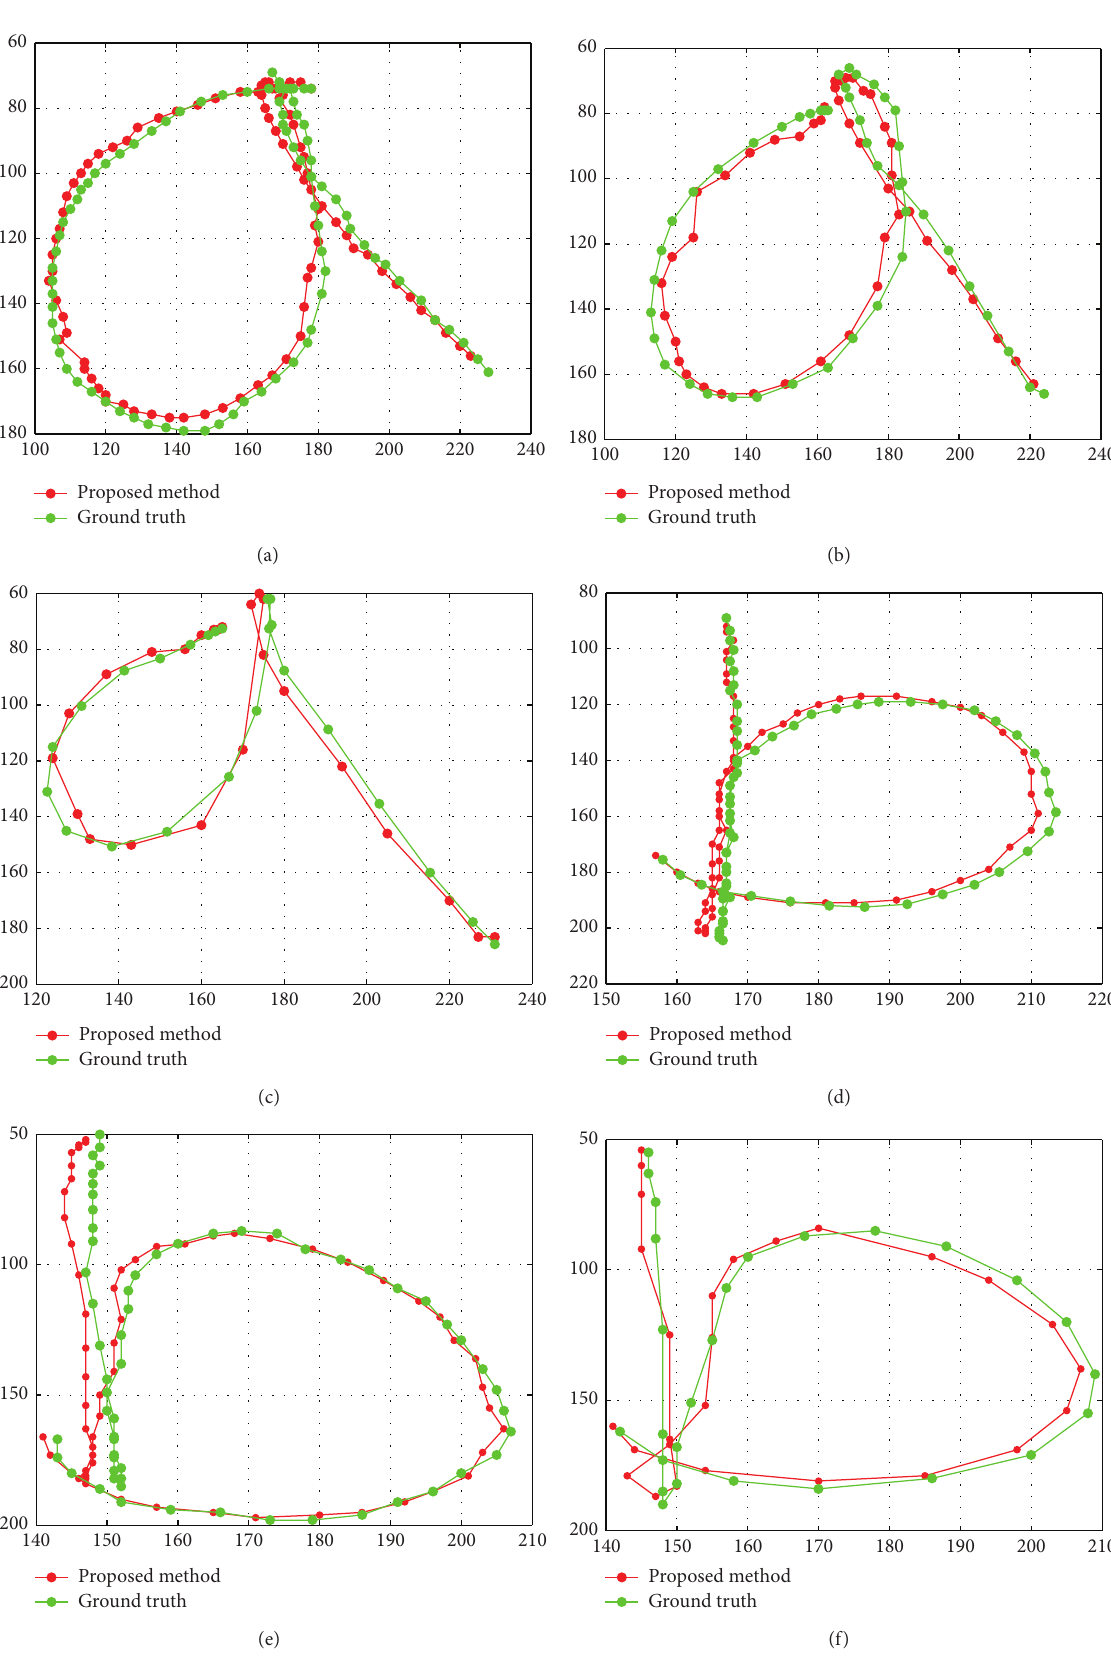
Figure 16: Tracking results of gestures “a” and “b” under various velocity